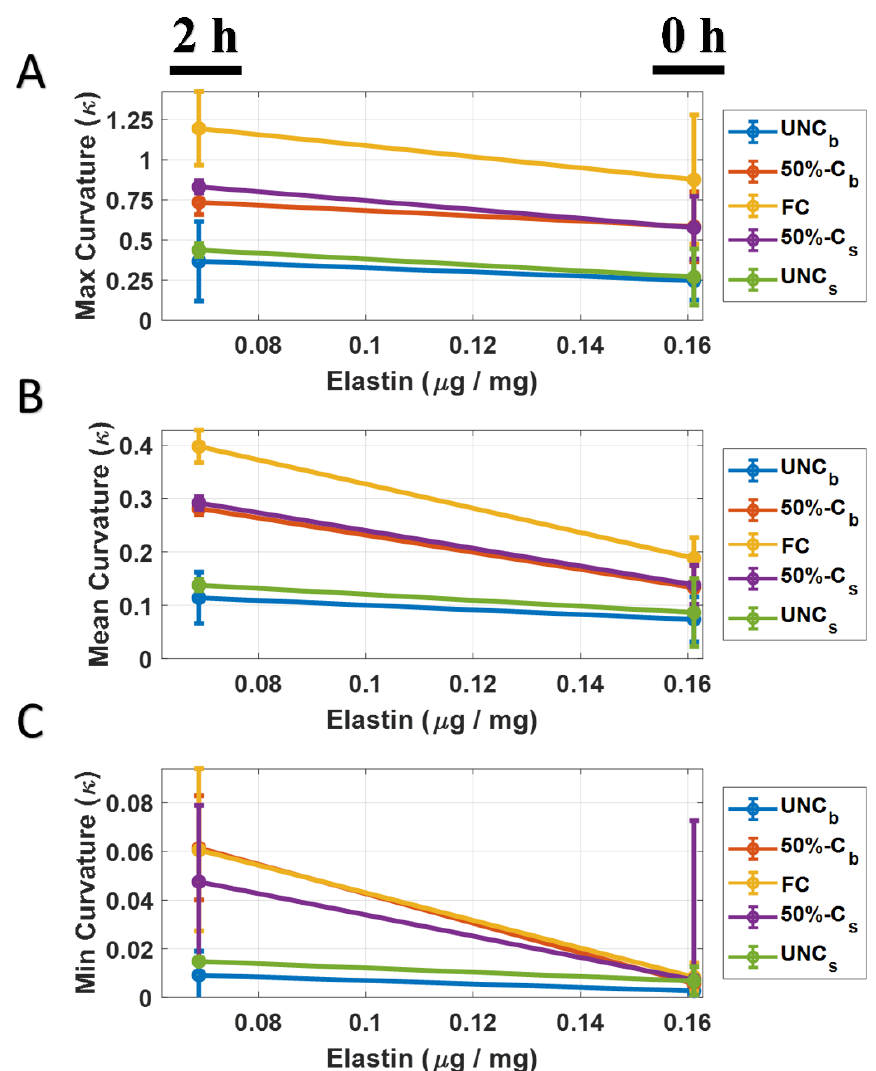
Figure 3. Elastin and curvature comparisons. ( A ) Maximum curvature with mean ± SEM plotted against elastin for 0 h and 2 h degradation time points for all bending phases. ( B ) Mean curvature with mean ± SEM plotted against elastin for 0 h and 2 h degradation time points for all bending phases. ( C ) Minimum curvature with mean ± SEM plotted against elastin for 0 h and 2 h degradation time points for all bending phases.